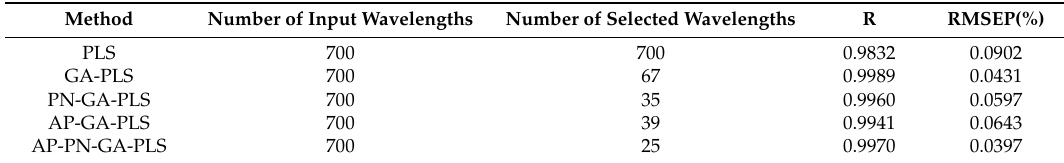
Table 4. The average values of the number of selected wavelengths, correlation coefficient (R), and predicted root mean square error (RMSEP) using PLS, GA-PLS, PN-GA-PLS, AP-GA-PLS, and AP-PN-GA-PLS (corn